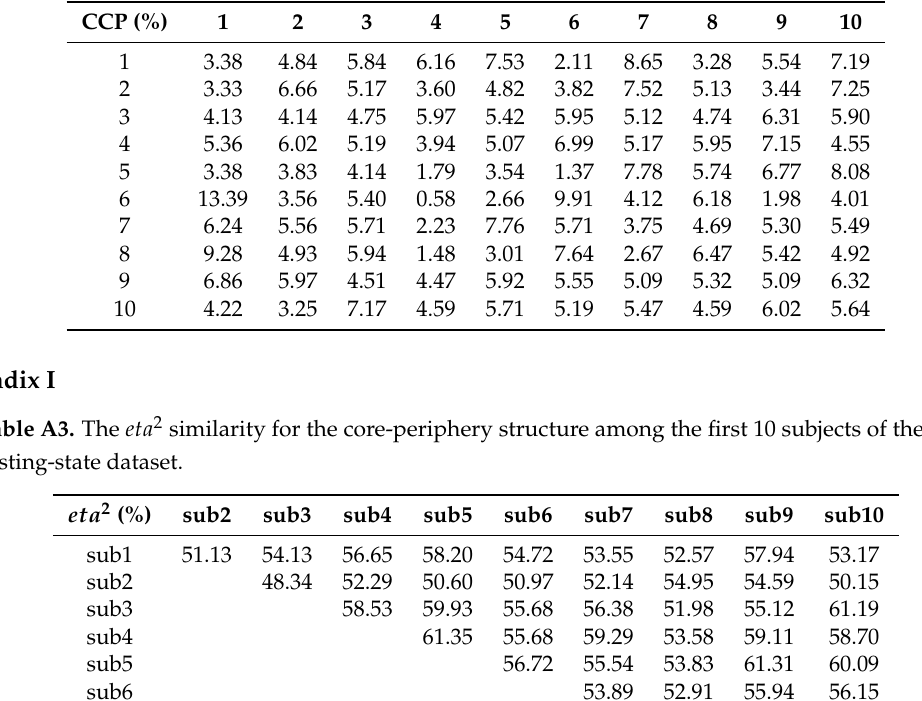
Table A2. The SOR value between the CCPs of the subject 1 and subject 2 in the manifold space.